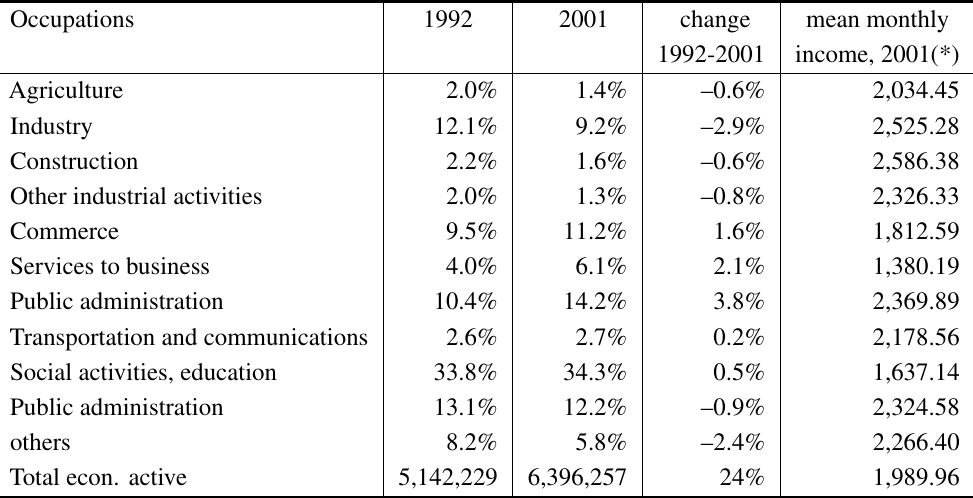
Occupations of persons with higher education, 1992-2001.